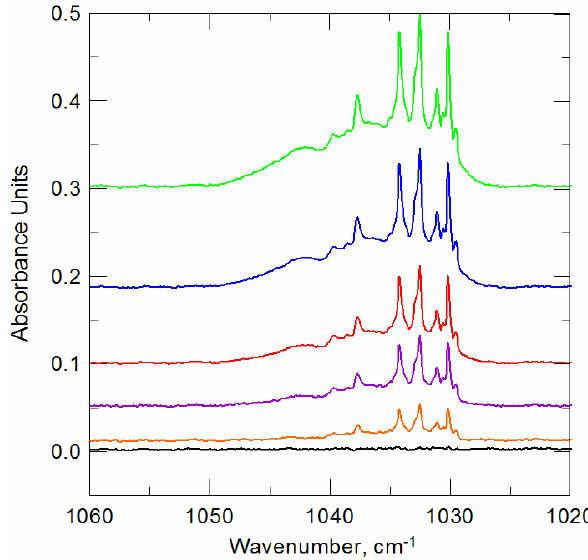
Fig. 2. Absorption spectra of solid molecular oxygen at T = 16K before irradiation (black line) and after 1 min (orange), 6min (pur- ple), 16min (red), 26min (blue) and 79min (green) of irradiation with the resonance hydrogen lamp (at a microwave generator power output of 30,W) showing the growth of the O 3 band multiplet in the 1040–1030cm − 1